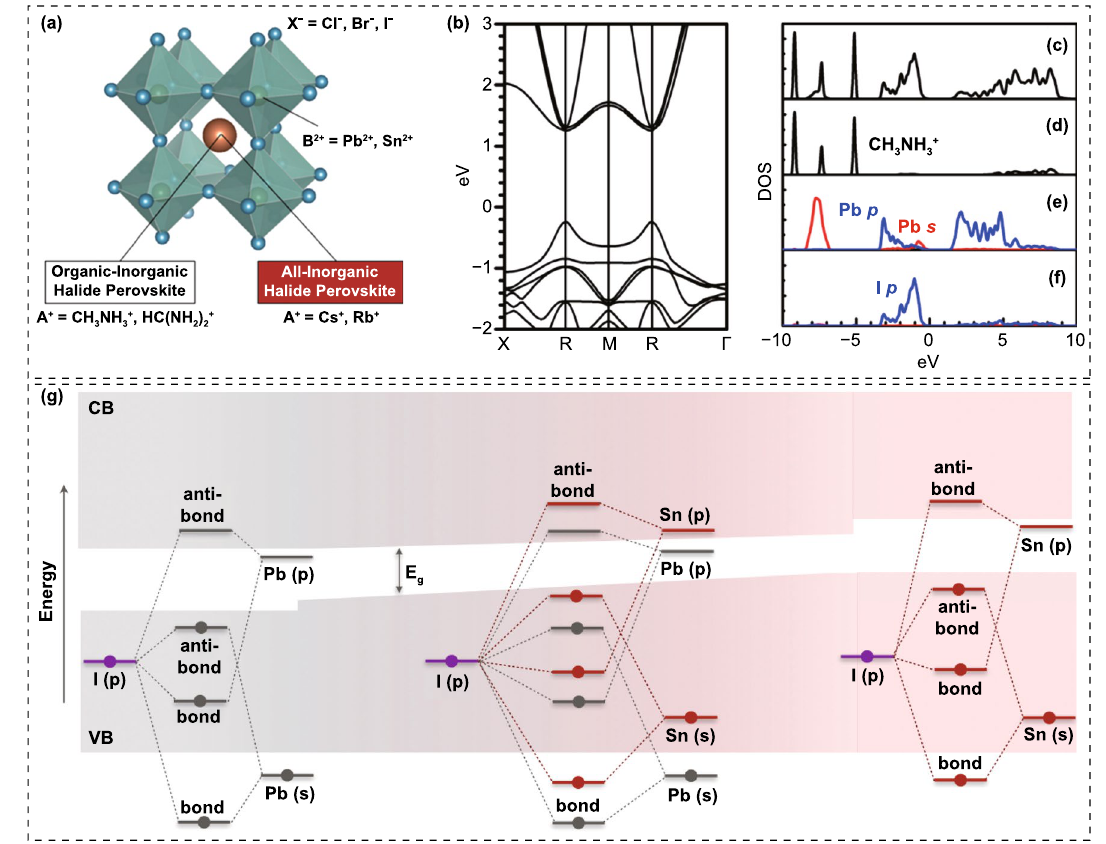
Fig. 2 a Typical ABX 3 crystal structure of halide perovskites. Reproduced with permission from Ref. [36]. Copyright 2019, Royal Society of Chemistry. b Band structure. c Total DOS. Partial DOSs of d MA + , e Pb, and f I. Reproduced with permission from Ref. [40]. Copyright 2014, AIP Publishing LLC. g Schematic of origin of the bandgap bowing in MA(Pb 1−x Sn x )I 3 . Reproduced with permission from Ref. [44]. Copyright 2018, American Chemical